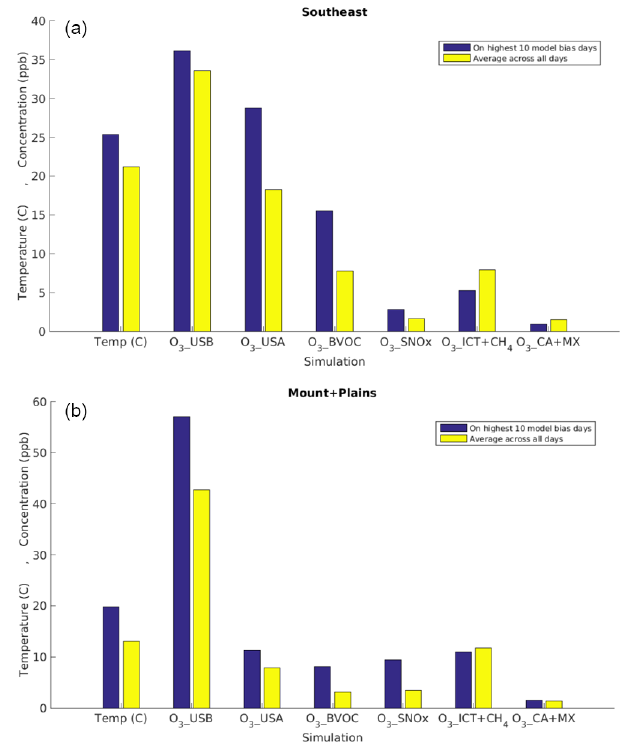
Figure 4. Multi-year (2004–2012) March–October average temper- ature and MDA8 O 3 source contributions estimated with the GEOS- Chem model in the (a) Southeast and (b) Mountain and Plains re- gions on the 10 most biased days (blue) versus averaged across all days (yellow). Note that the two regions are on different